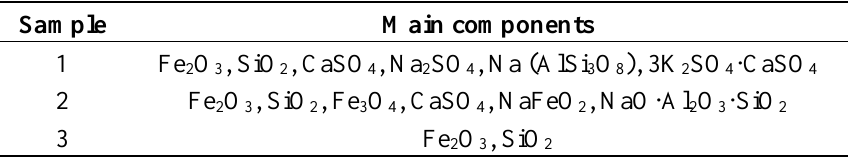
Figure 6. XRD analysis pictures of the ash samples. ( a ) Sample 1; ( b ) Sample 2; ( c ) Sample 3. Table 8. XRD analysis results of the ash samples.